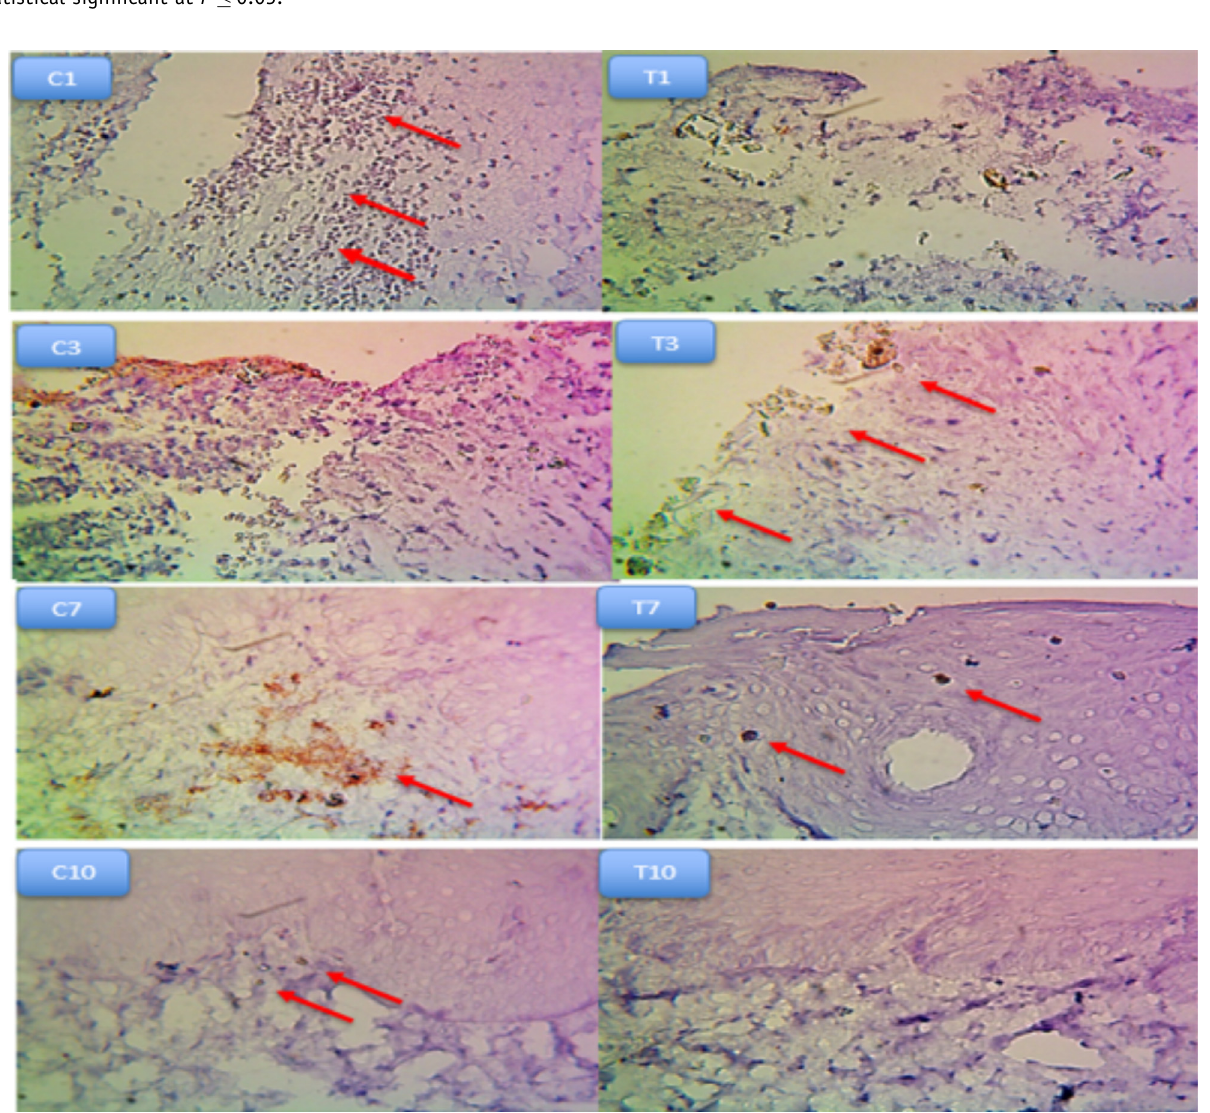
Fig. 2. Photomicrographs of rabbit oral mucosa for immunohistochemical examination of TNF- a . C1: Heavy expression of TNF- a (arrows) in control group compared to (T1) treatment group at one-day interval reveals heavy in fi ltration of in fl ammatory cells. C3: TNF- a also continue to express in control group, while reduced in treatment group (arrows) (T3) at three-day interval. C7&T7: Control and treatment group at seven-day interval, showed remission of TNF- a in (T3) in contrast to (arrows) (C7) control group (arrow). C10: Control group appeared slightly expression of TNF- a (arrows) compared to completely absence of TNF- a in (T10) treatment group at 10-day interval. 100 (cid:3)